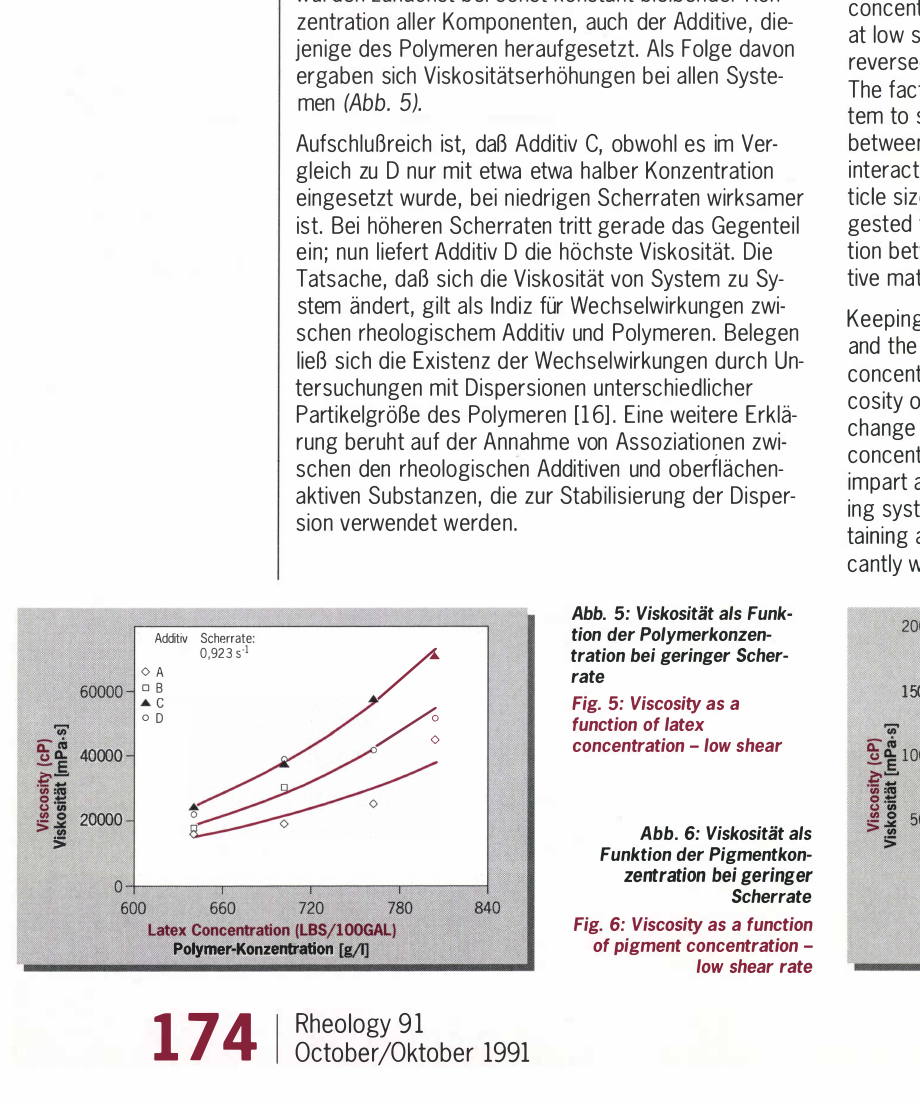
Fig. 6: Viscosity as a function of pigment concentration - low shear